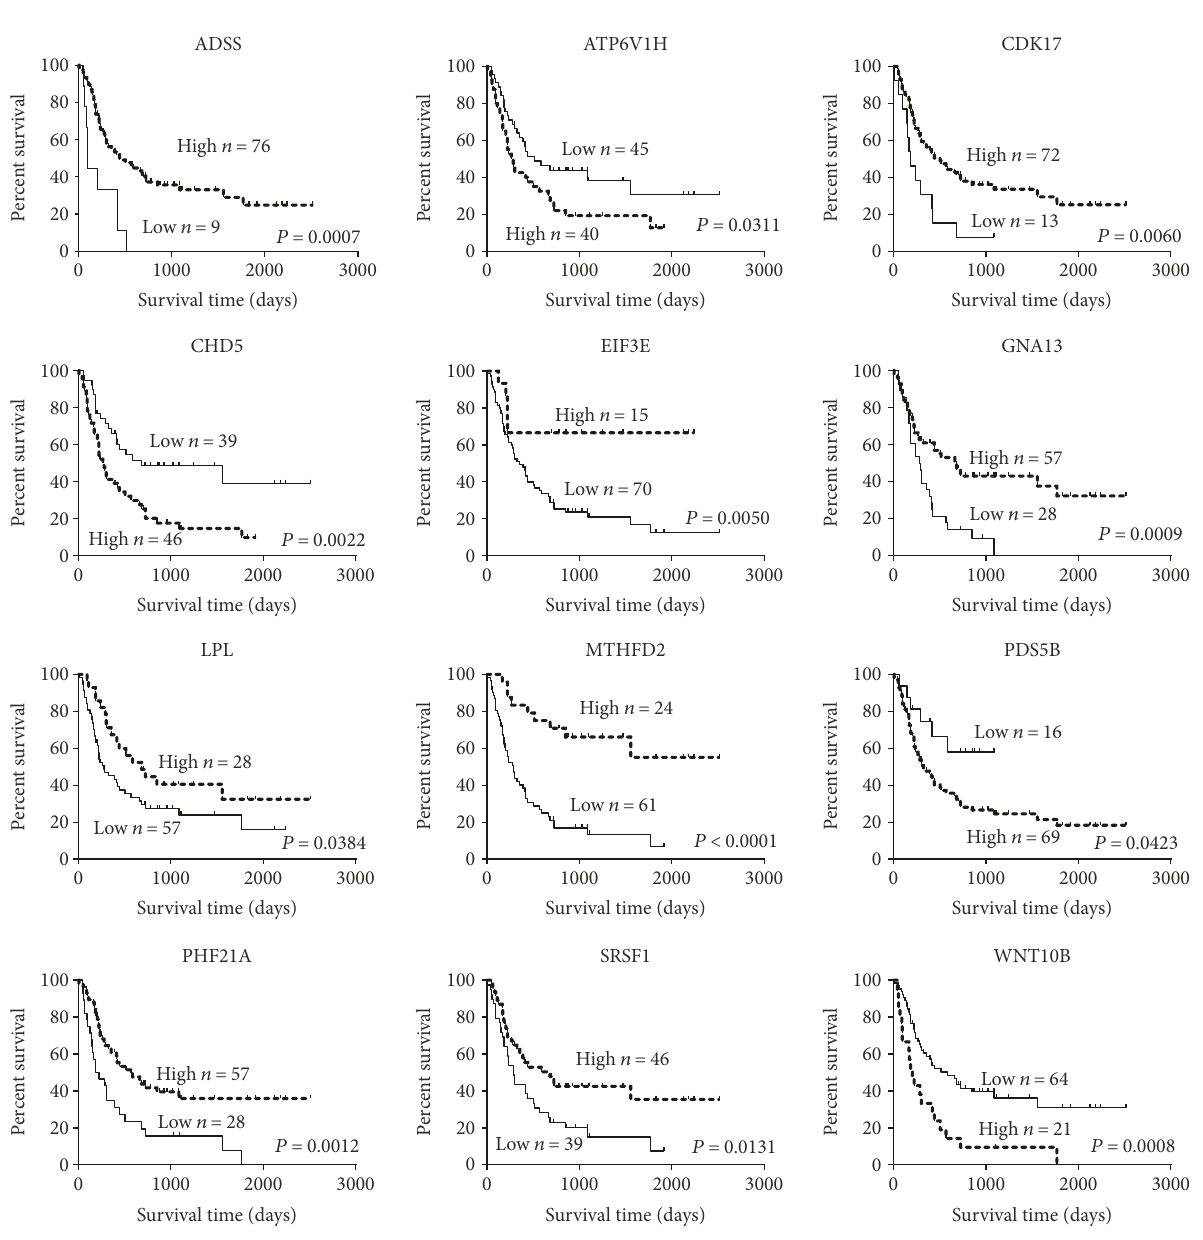
Figure 3: Kaplan-Meier analysis of overall survival for 12 hub genes in the generation dataset of 85